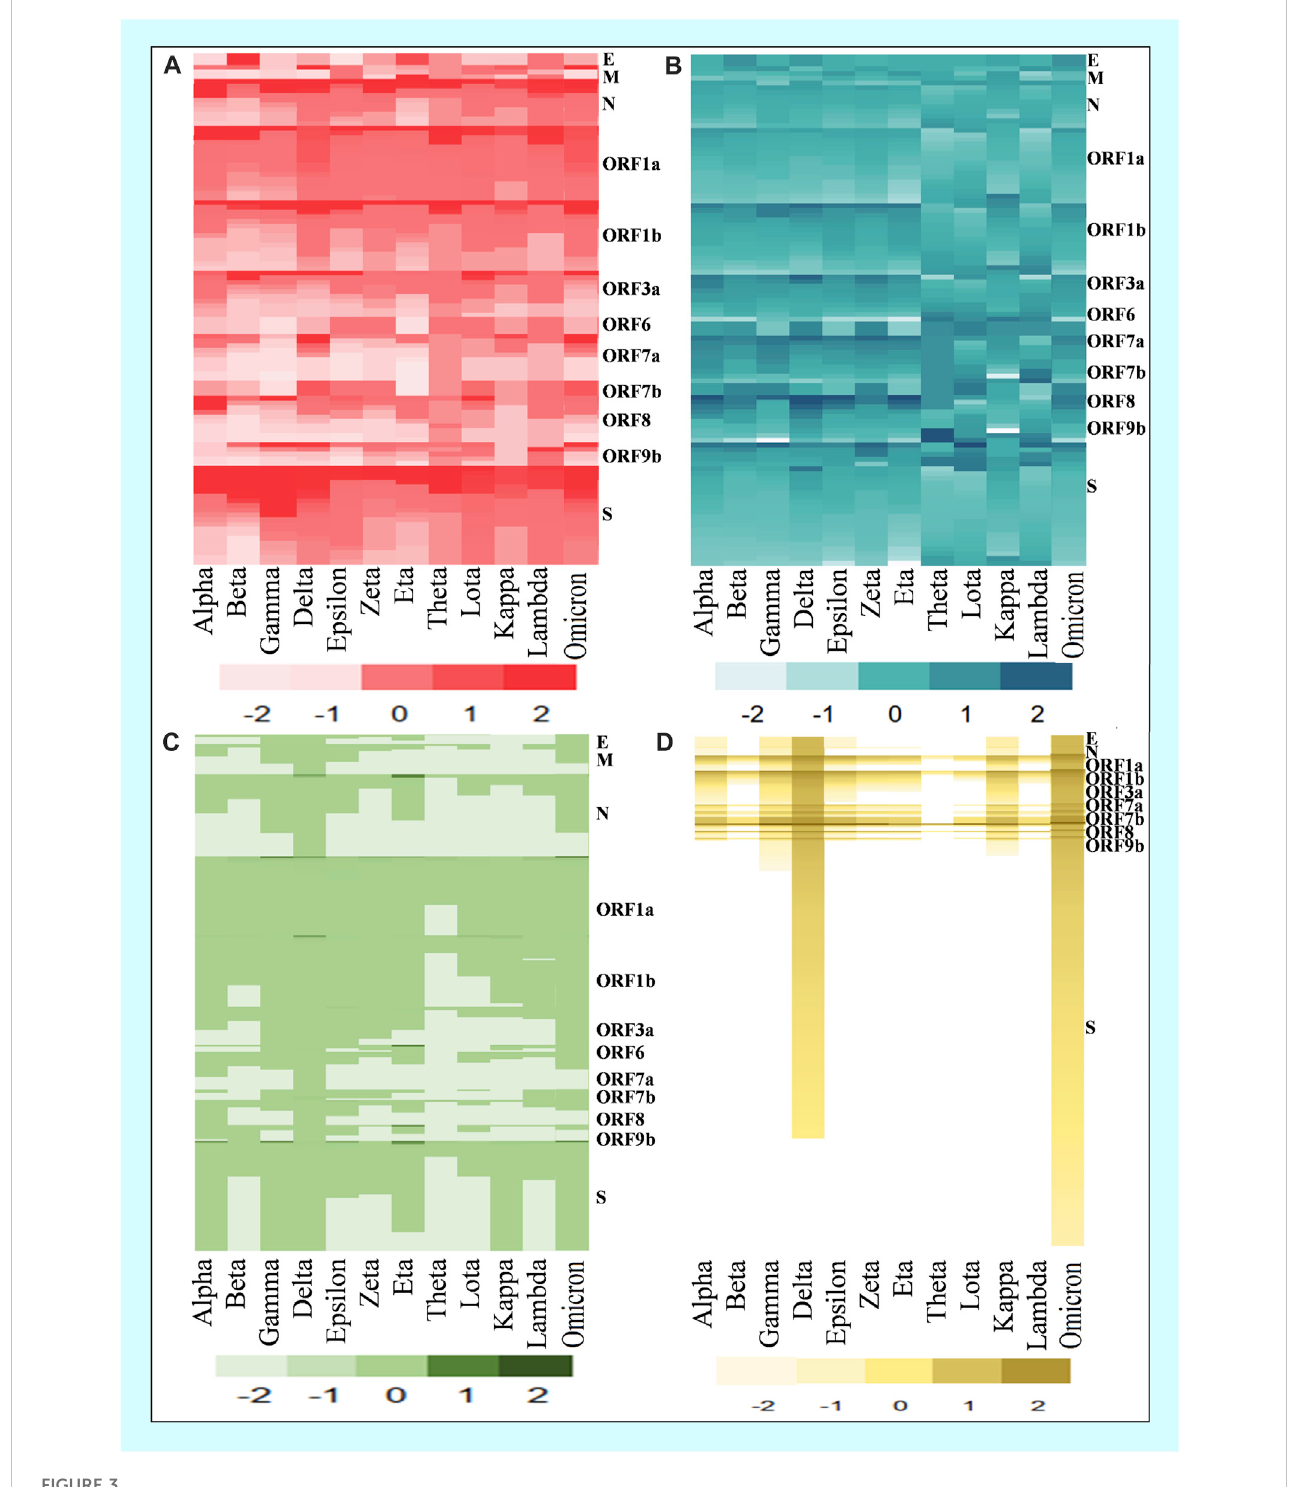
FIGURE 3 Comparison ofcommonanduniquedeleteriousmutationpatternsindifferentvariants. (A) Frequencyoftopcommondeleteriousmutationsofdifferent proteins in twelve variants. (B) Deleterious mutation score of common mutations. (C) Frequency of top unique deleterious mutations of different proteins in twelve variants. (D) Deleterious mutation score of unique